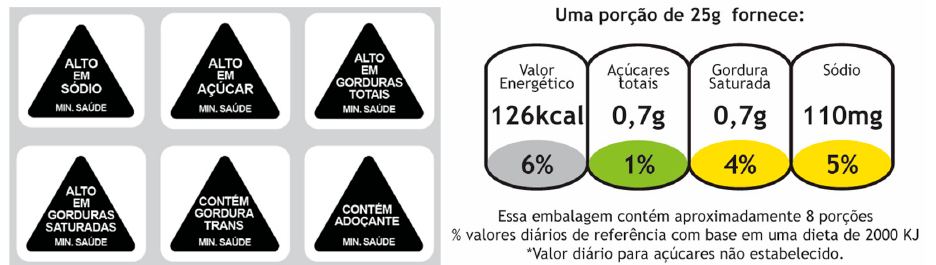
Figure 1. Label conditions.